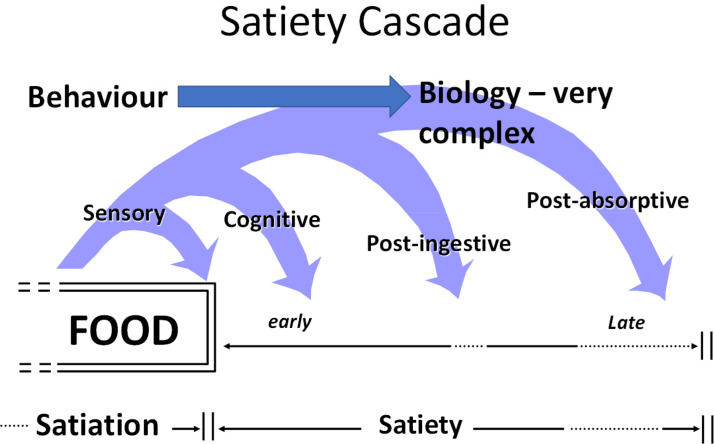
Satiety cascade(7).